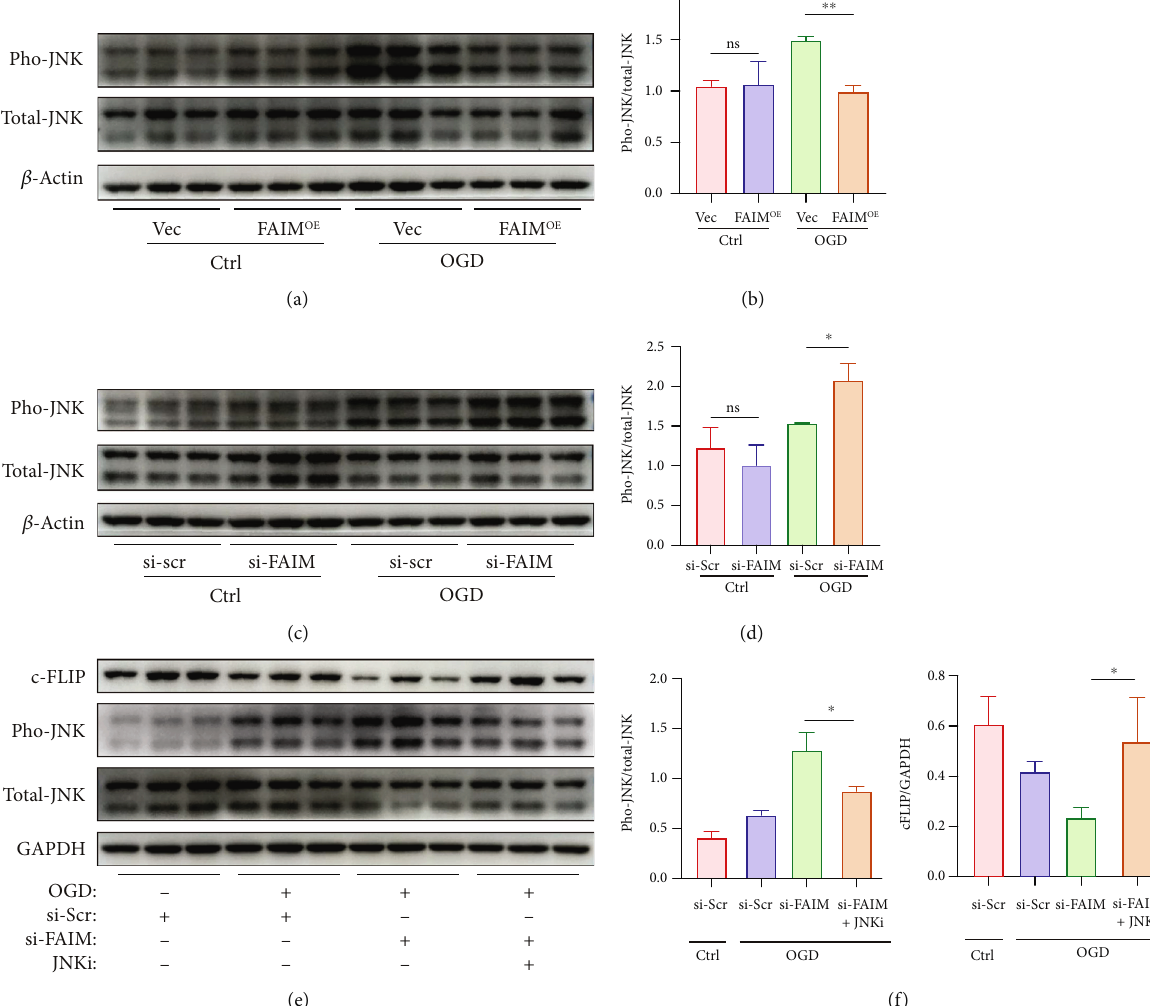
Figure 6: FAIM reduces c-FLIP degradation by blocking JNK activation. (a – b) Immunoblots and densitometric quantitation of phosphorylated JNK and total JNK protein expression in MSCs conditions. (e – f) Phosphorylated JNK, total JNK, and c-FLIP protein expression after siRNA-mediated knockdown of FAIM or scrambled siRNA administration followed by treatment with SP600125 (a JNK inhibitor, 10 μ M) or DMSO under OGD conditions. The data are shown as the mean ± SD . Ns indicates not signi fi cant; ∗ denotes P < 0 : 05 ; ∗∗ P < 0 : 01